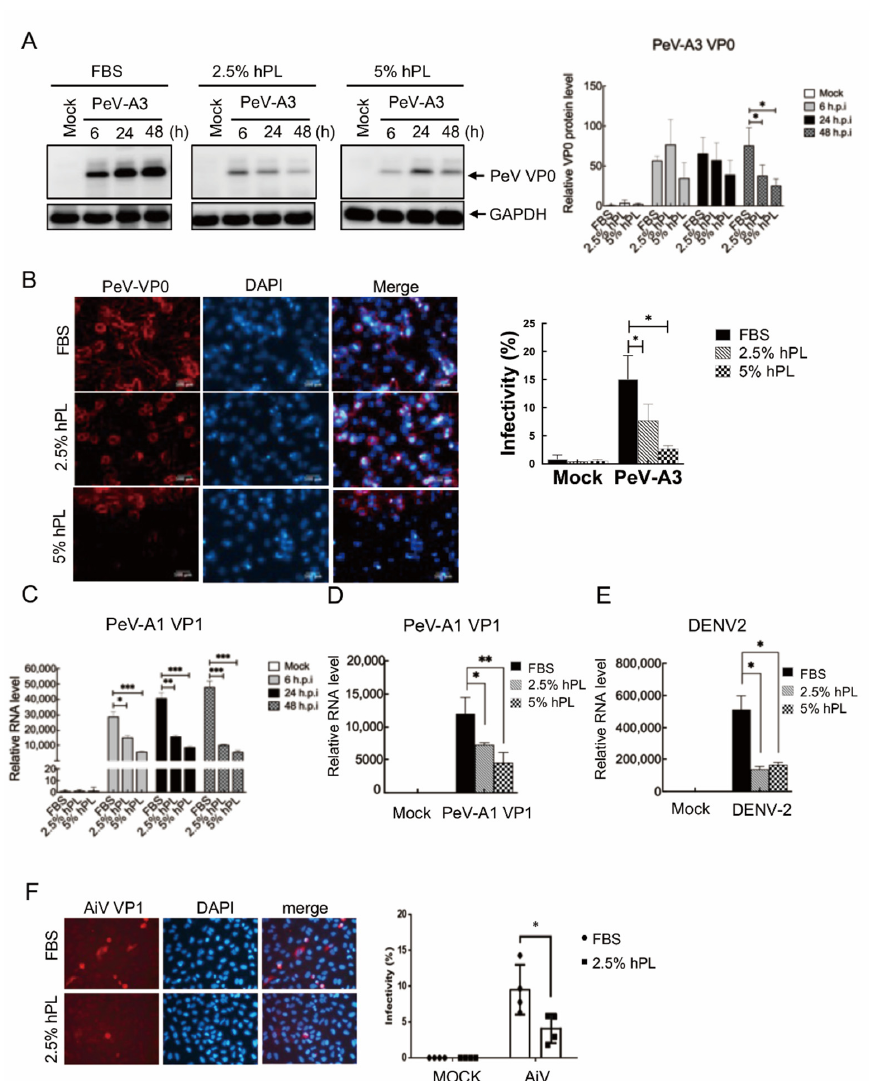
Figure 2. GBM cells infected with PeV-A3 and other viruses showing reduced viral protein and viral RNA expression under hPL medium compared with FBS medium. ( A ) GBM cells were infected with PeV-A3 at MOI = 1 for 6 h, 24 h, and 48 h under FBS- and hPL-supplemented mediums. Protein lysates were examined by immunoblotting using anti-PeV-VP0 and anti-GAPDH (left panels). Quantification of protein expression was normalized to GAPDH. Data are mean ± SD of three independent experiments. Student’s t -test, *, p < 0.05 (right panel). ( B ) BGM cells were infected with PeV-A3 at MOI = 1 for 48 h. Cells were then stained with anti-PeV-VP0 antibody followed by goat anti-rabbit IgG secondary antibody. Scale bar = 100 µ m (left panels). Quantified PeV-A3 infected GBM cells of immunofluorescence assay are shown. Data are mean ± SD. Student’s t -test, *, p < 0.05 (right panel). ( C , D ) RNA level of PeV-A3 VP1 and PeV-A1 VP1 genes under serum and serum substitute mediums. mRNA levels of PeV-A3 VP1 and PeV-A1 VP1 were measured and normalized using GAPDH. Student’s t -test, *, p < 0.05; **, p < 0.01, ***; p < 0.001 compared with FBS. ( E ) GBM cells were infected with DENV-2 at MOI = 1 for 24 h under FBS- and hPL-cultured mediums. mRNA level of DENV-2 was measured and normalized using GAPDH. Data are mean ± SD of three independent experiments. Student’s t -test, *, p < 0.05. ( F ) A549 cells were infected with AiV at MOI = 1 for 48 h. Cells were then stained with anti-AiV VP1 antibody followed by goat anti-rabbit IgG secondary antibody. Scale bar = 100 µ m. (left panels). Quantified AiV VP1 infection levels of immunofluorescence assay of A549 cells are shown as scattered plots. Data are mean ± SD. Student’s t -test, *, p < 0.05 (right